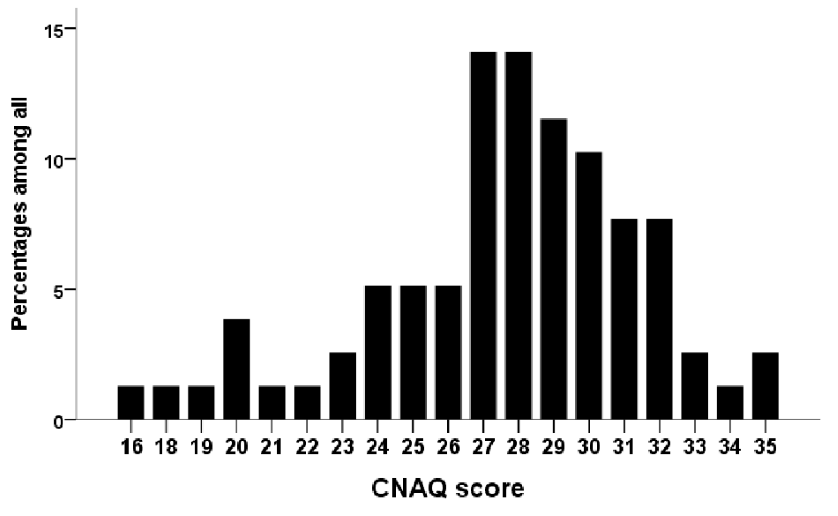
Figure 1. The distribution of the CNAQ scores in the current cohort. CNAQ, Council on Nutrition Appetite Questionnaire. Table 1. Characteristics of patients with chronic kidney disease with and without an impaired appetite.